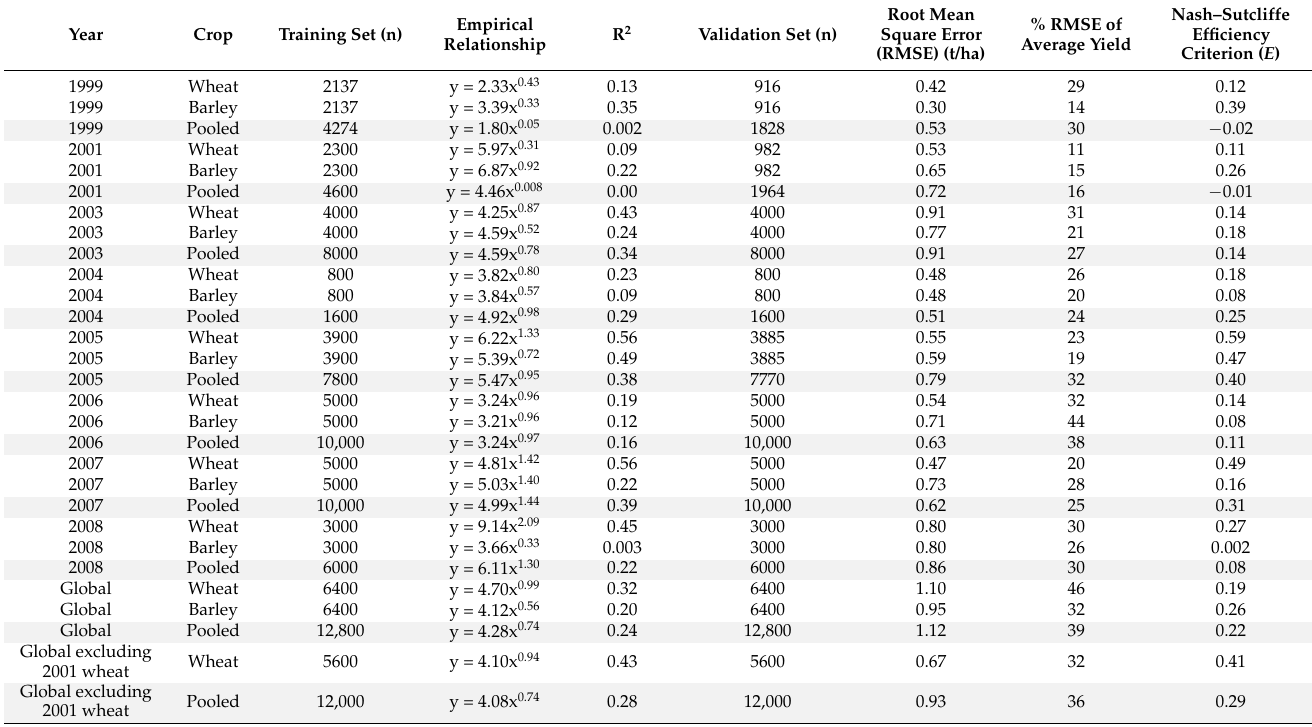
Table 2. Power empirical relationships, R 2 and efficiency criteria (root mean square error (RMSE), % of RMSE of average yield and the Nash–Sutcliffe Efficiency Criterion ( E )) for the annual wheat and barley and global yield prediction models within the